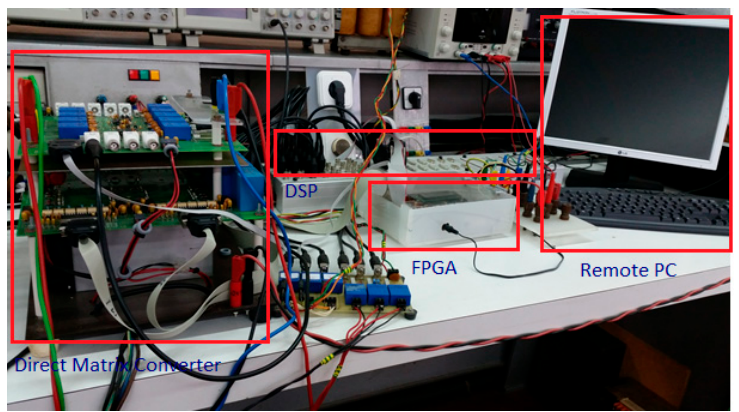
( b ) Figure 11. Harmonic content of the line currents ( a ) and of the load voltages ( b ).